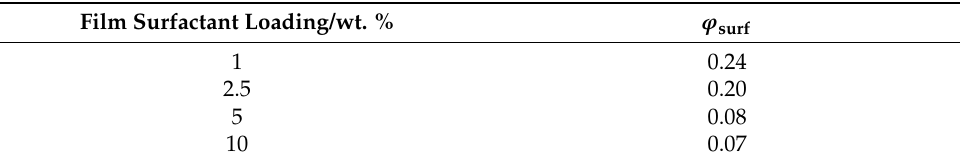
Table 3. Surface fractions for cis -PI/C 12 E 5 at 20 ◦